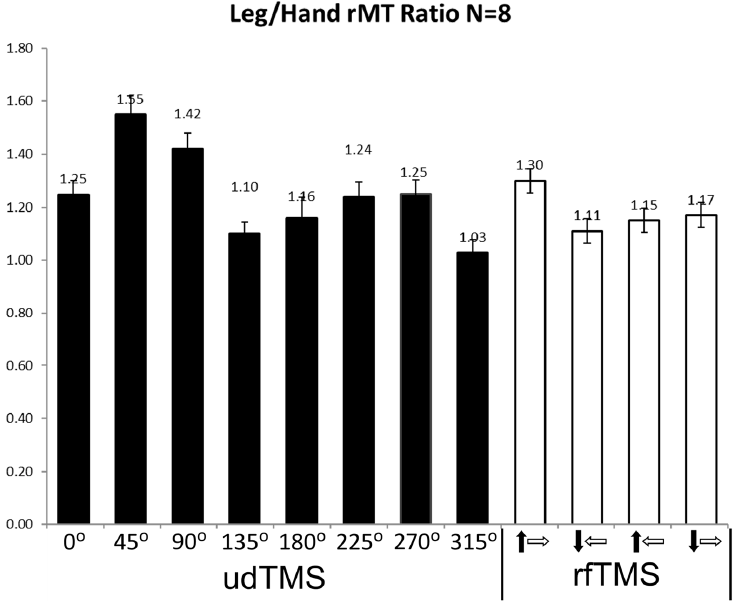
Figure 7. Ratio of leg tibialis anterior (TA) and hand abductor policis brevis (APB) rMTs for various udTMS orientations, and for four rfTMS states. The black and white arrows represent the polarity induced during the second stroke of the biphasic pulse by the lower and upper coils, respectively. Shown are mean ± SE.